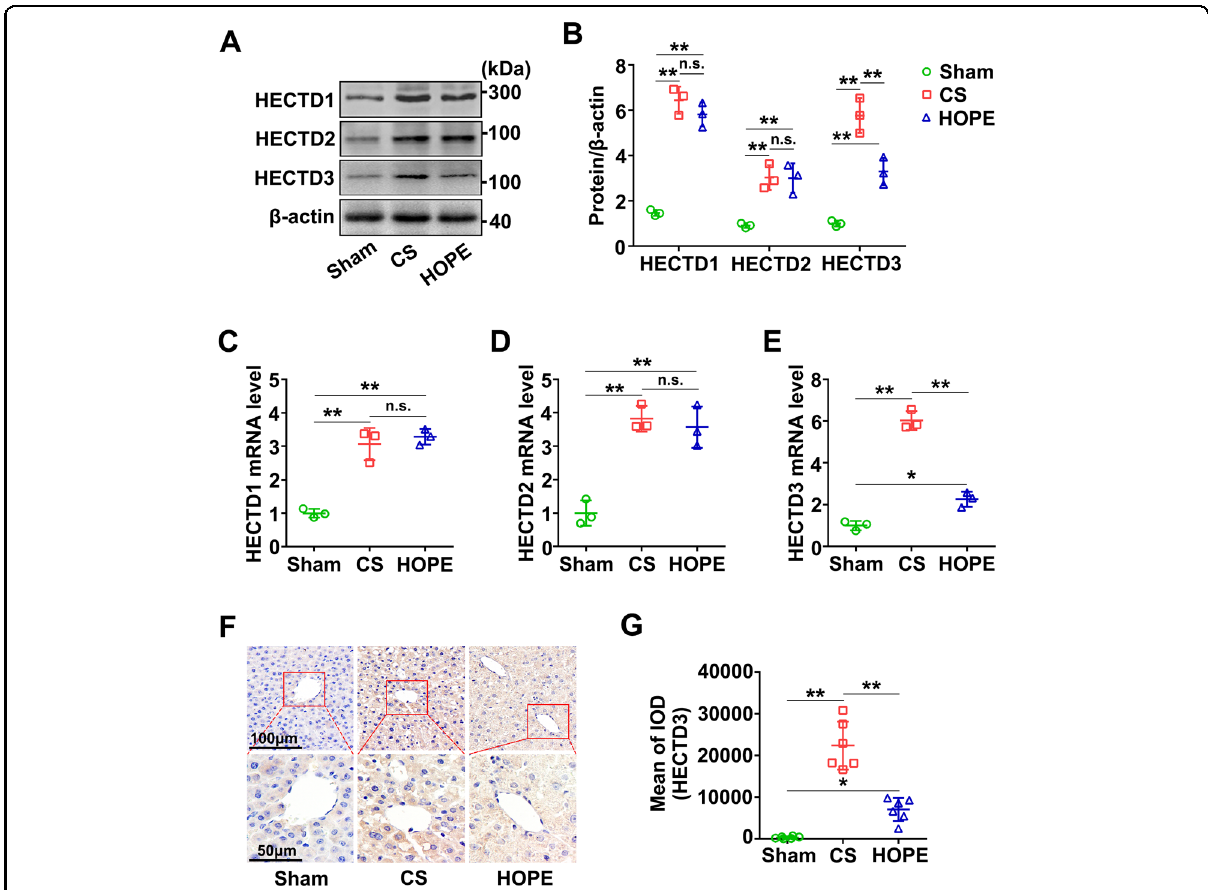
Fig. 3 HOPE inhibits the expression of HECTD3 in a DCD rat model. A, B HECTD1, HECTD2, and HECTD3 proteins expression in liver were evaluated using western blot ( A ) and quanti fi ed using a Gel-Pro Analyzer ( B ). Data are mean ± SD, n.s., not signi fi cant; ** P < 0.01 by two-way ANOVA followed by Tukey ’ s test. n = 3 per group. C – E mRNA expression level in liver of HECTD1, HECTD2 and HECTD3 were tested by real-time PCR. Data are mean ± SD, n.s., not signi fi cant; * P < 0.05 and ** P < 0.01 by one-way ANOVA followed by Tukey ’ s test. n = 3 per group. F IHC staining of HECTD3 were performed on paraf fi n-embedded section of rat liver tissues. Scale bar = 100 μ m (upper panels) and 50 μ m (down panels). G IHC stained fl uorescence of HECTD3 was quanti fi ed using Image-pro plus 6.0. Data are mean ± SD, * P < 0.05 and ** P < 0.01 by one-way ANOVA followed by Tukey ’ s test. n = 6 per